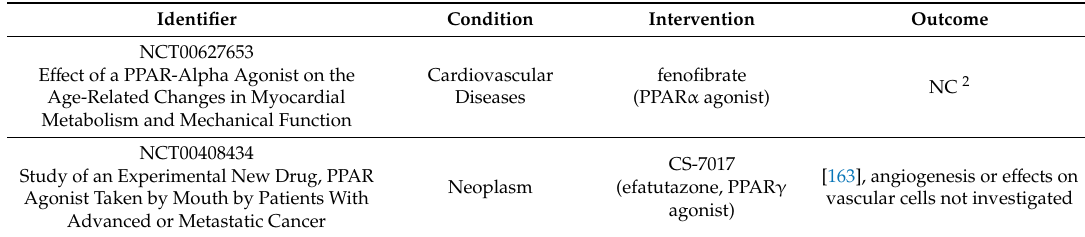
Table 2. PPAR modulators in Clinical Studies Related to This Review 1